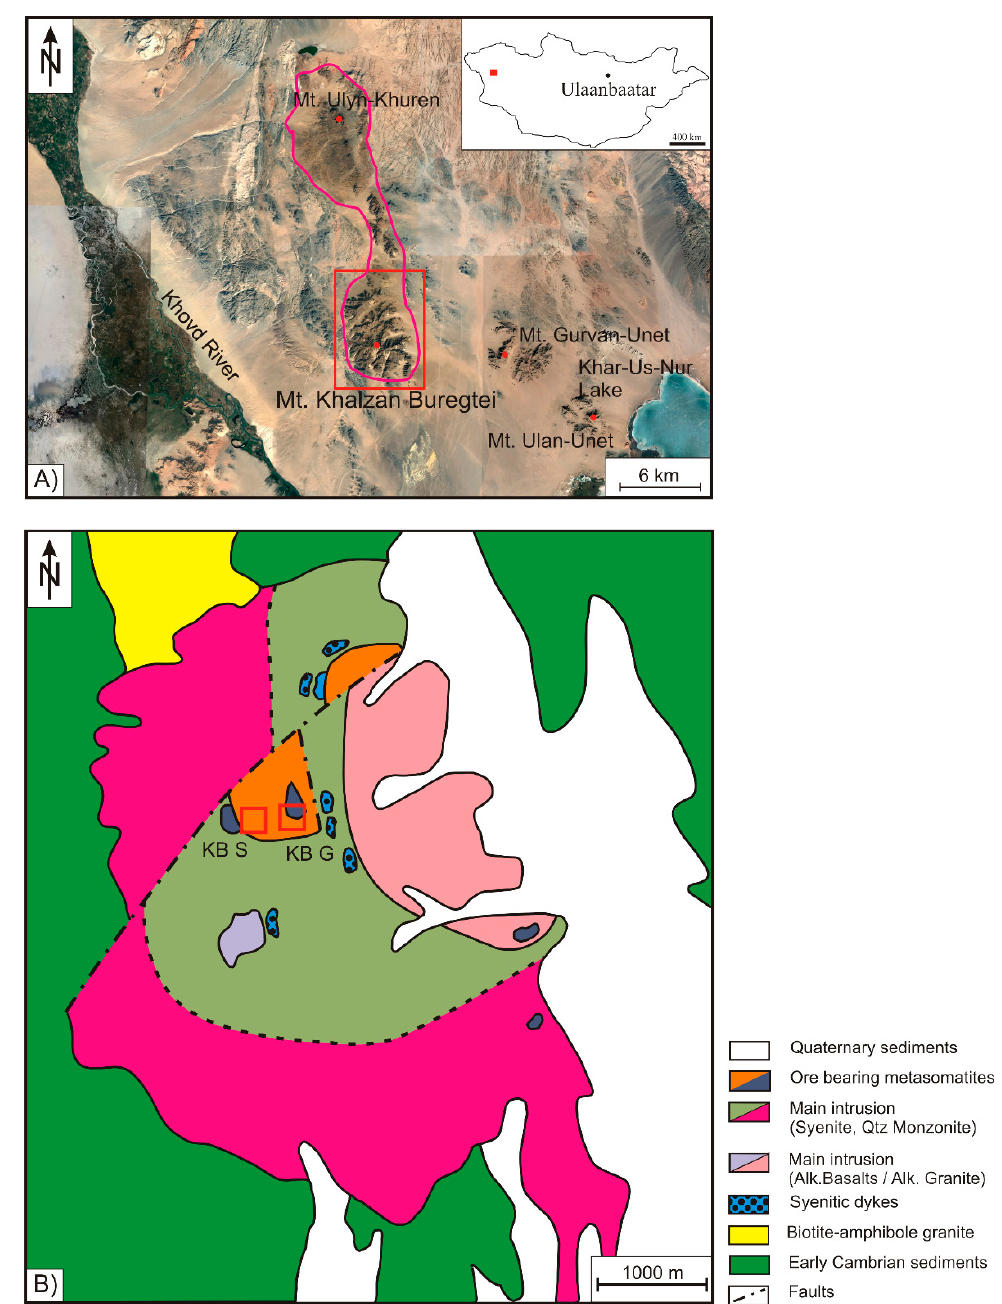
Figure 1. ( A ) Satellite image with the outline (magenta) of the entire alkaline massif of Khalzan Buregtei as proposed by [13,15]. The red box marks the area of the Khalzan Buregtei deposit shown as sketch map in B [16]. ( B ) Geological sketch map of the Khalzan Buregtei Zr-REE-Nb deposit with sampling areas KB S and KB G, see text for further details. Map basis according to [12,15] with nomenclature following [5].